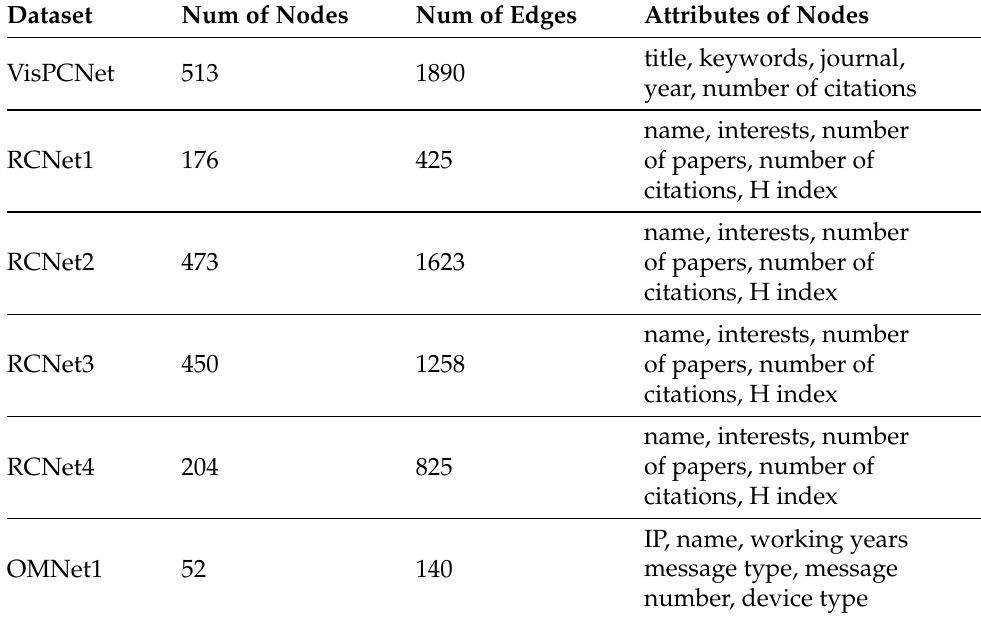
Table 1. Illustration of the